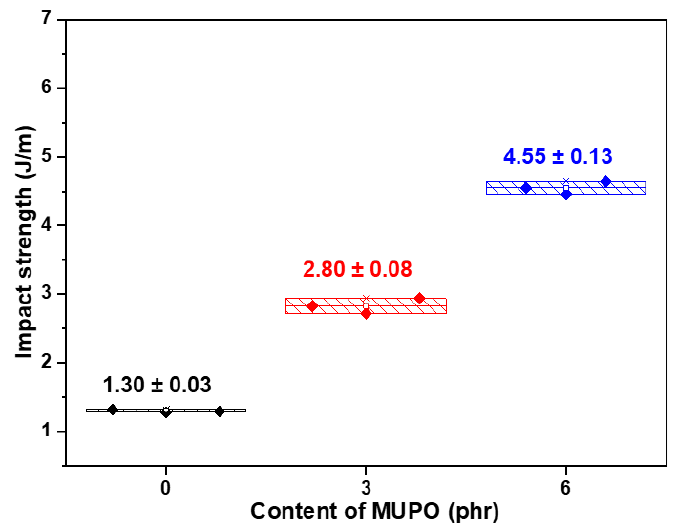
Figure 4. The impact strength of non-glutinous starch foam with various mUPO content—0, 3 and 6 phr.